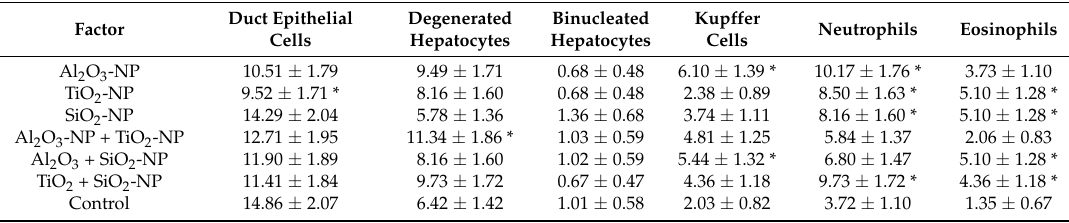
Table 8. Some Cytological Characteristics of Rat Liver Tissue Imprints as a Percentage of Total Cell Count in Rats after Subchronic Exposure to Al 2 O 3 -NP, TiO 2 -NP and SiO 2 -NP Individually or in Binary Combinations (x ± s.e.).